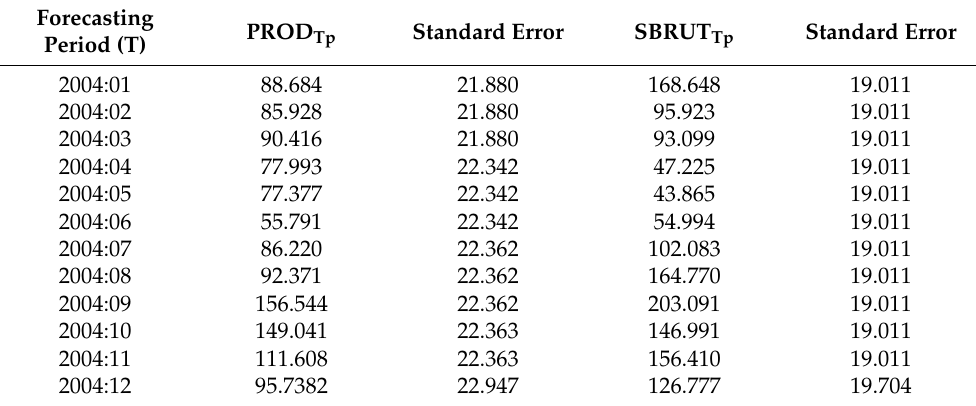
Table 5. Monthly forecasts of production (PROD Tp ) gross sales revenues (SBRUT Tp ) for the year 2004.